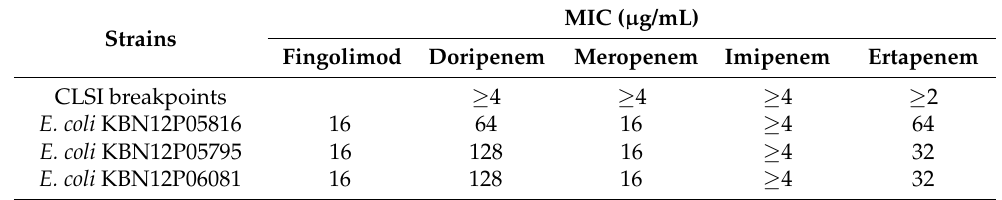
Table 1. Minimum inhibitory concentration of fingolimod and carbapenems against E. coli strains.